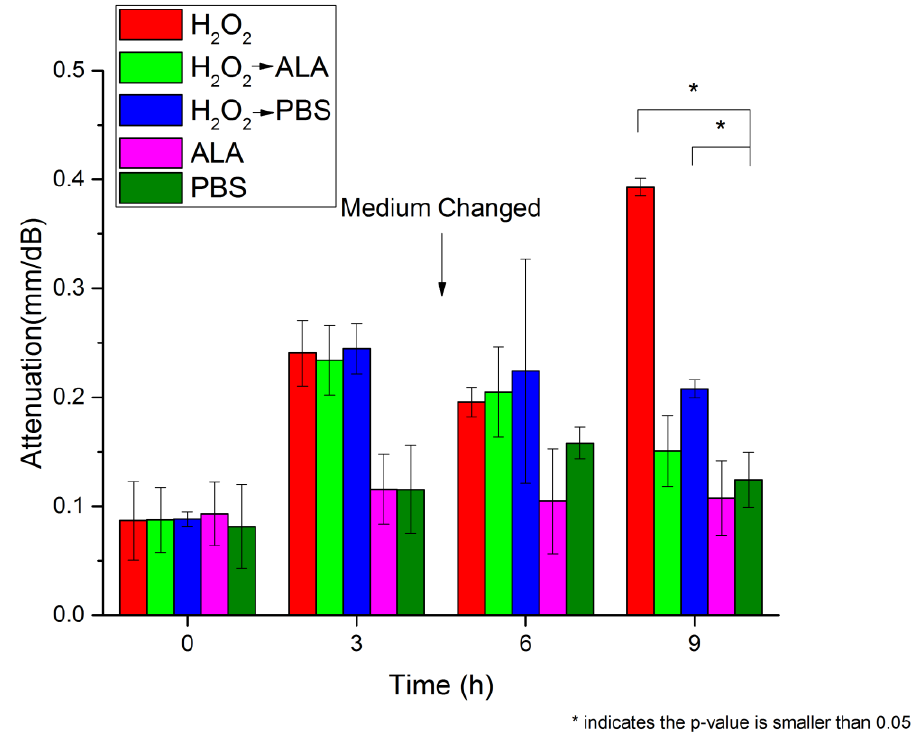
Figure 3. The attenuation calculated from the OCT images of the lenses incubated with five different media. The data is presented at the intersample mean ± standard deviation (N = 3 for each group). The asterisks indicate statistical significance ( p < 0.05) determined by Student’s t -test.